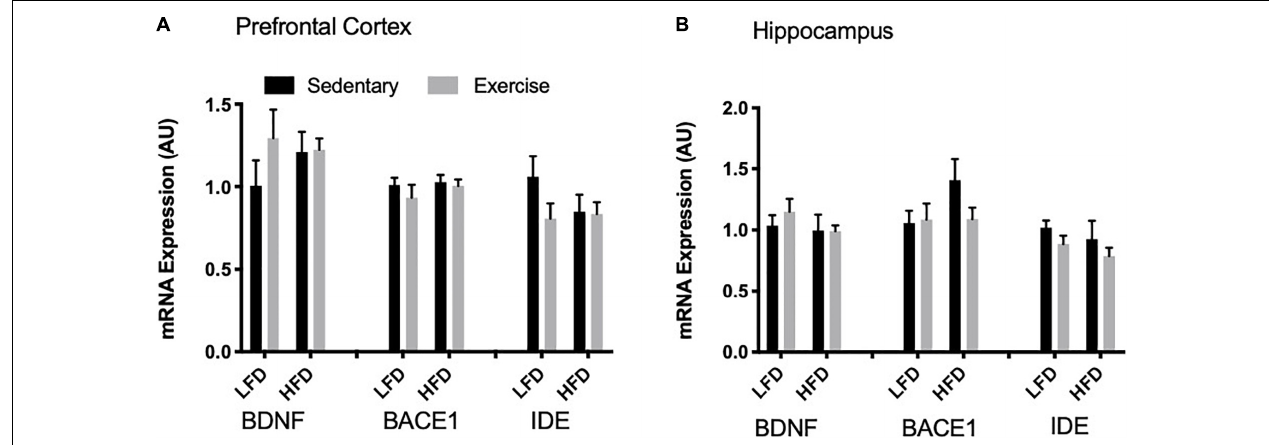
FIGURE 6 | mRNA expression. (A) There were no detectable changes in BDNF, BACE1 and IDE mRNA expression in the prefrontal cortex. (B) There were no detectable changes in BDNF, BACE1 and IDE mRNA expression in the hippocampus. Values are represented as mean ±